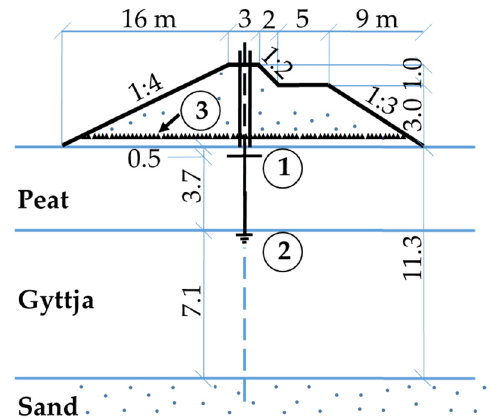
Figure 3. Test embankment at the Wonie ść site: 1–surface settlement gauge, 2–deep settlement gauge. 3–reinforcement steel mattress. gauge. 3—reinforcement steel